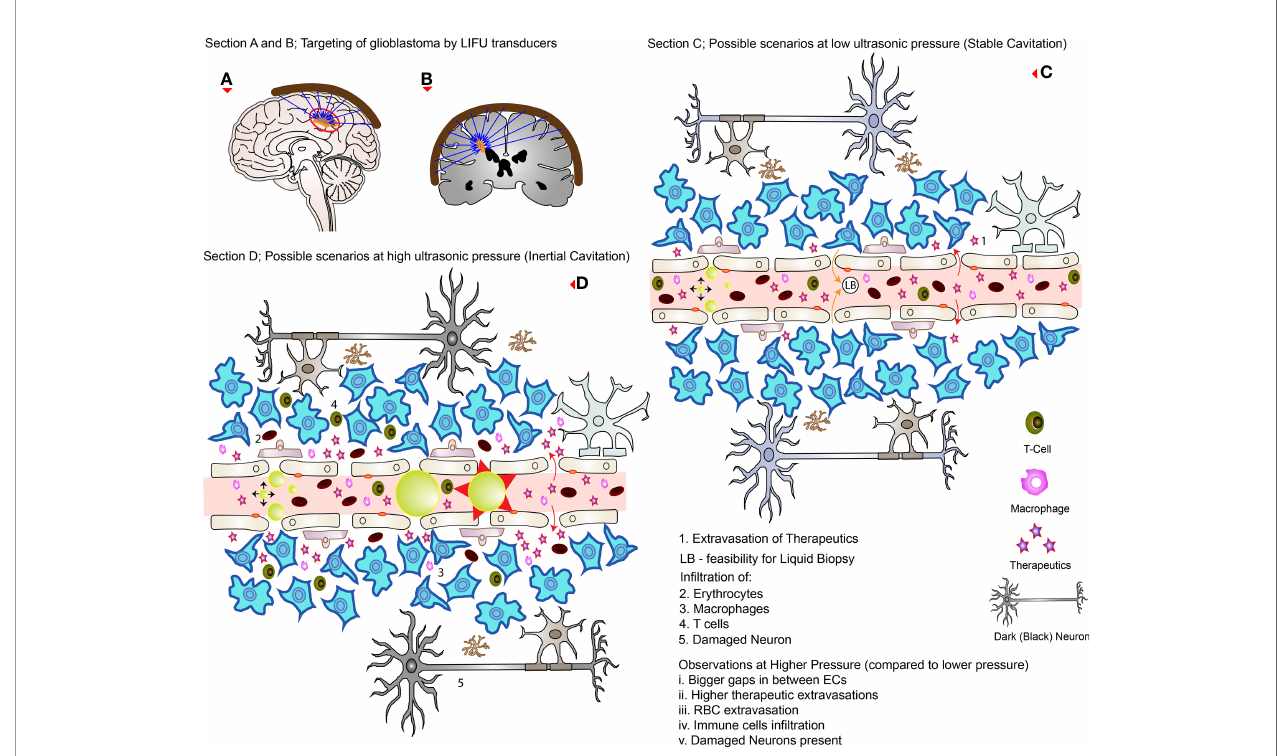
FIGURE 3 | LIFU targeting and its effects during high and low pressures. (A, B) How external transducers (around the brain) target glioblastomas in practice by the converging ultrasound waves (in the direction of the blue arrows). (C) The possible scenarios at low pressure (stable cavitation); the RBC, and immune cells are con fi ned to the blood vessels while disrupting TJs and creating openings with low levels of therapeutic extravasation. (D) The possible scenarios at higher pressure (inertial cavitation) where there is greater concentration of drugs delivered with wider openings between the ECs. Note that there is MB collapse, immune cells, and RBC extravasations as well as affected neurons (which appears dark on analysis). The red arrows (curved full arrows) represent drug extravasation while the orange arrows (curved full arrows) represent the feasibility of liquid